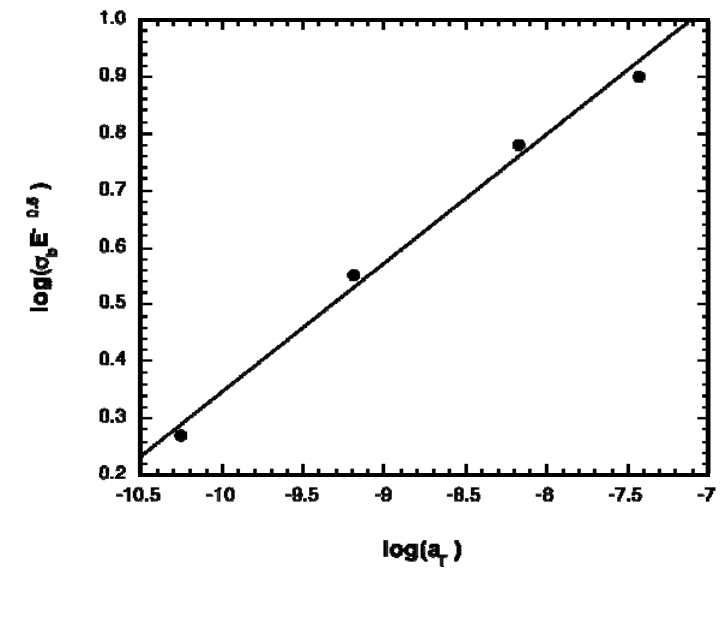
Figure 1. Relationship between shift factor (a modulus